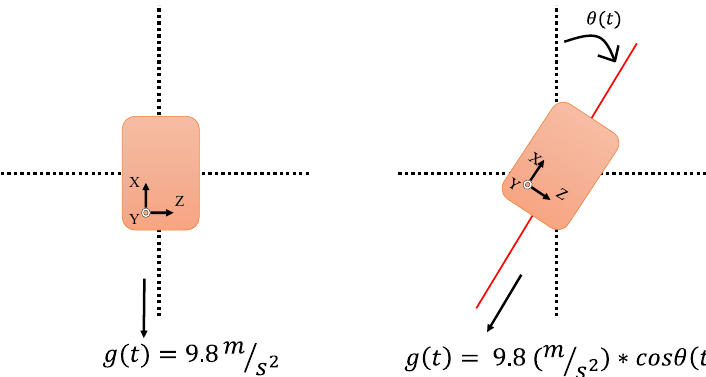
Figure 2. Adjusting gravity influence via angle θ ( t ) correction.